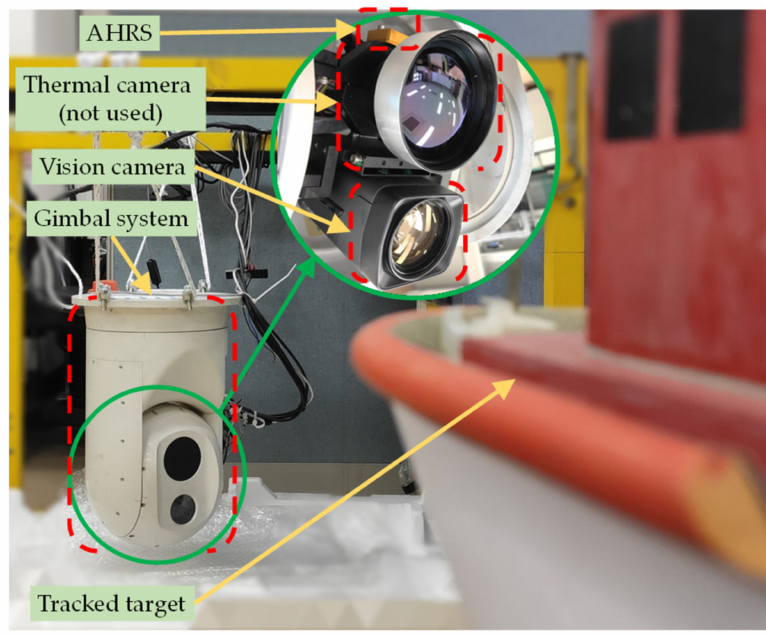
Figure 7. The target tracking